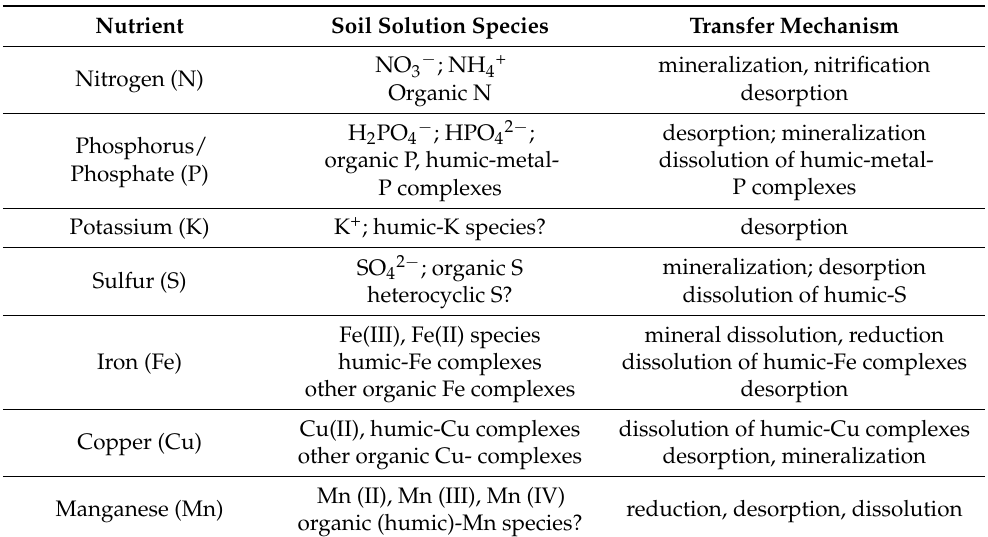
Table 1. Selected chemical macronutrient and micronutrient species in the soil solution and the mechanisms of transfer into the soil